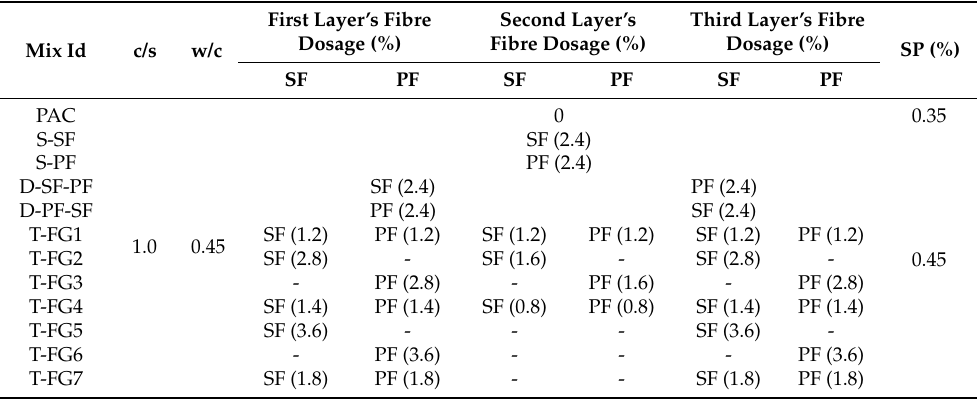
Table 1. Mixing composition of the composite.